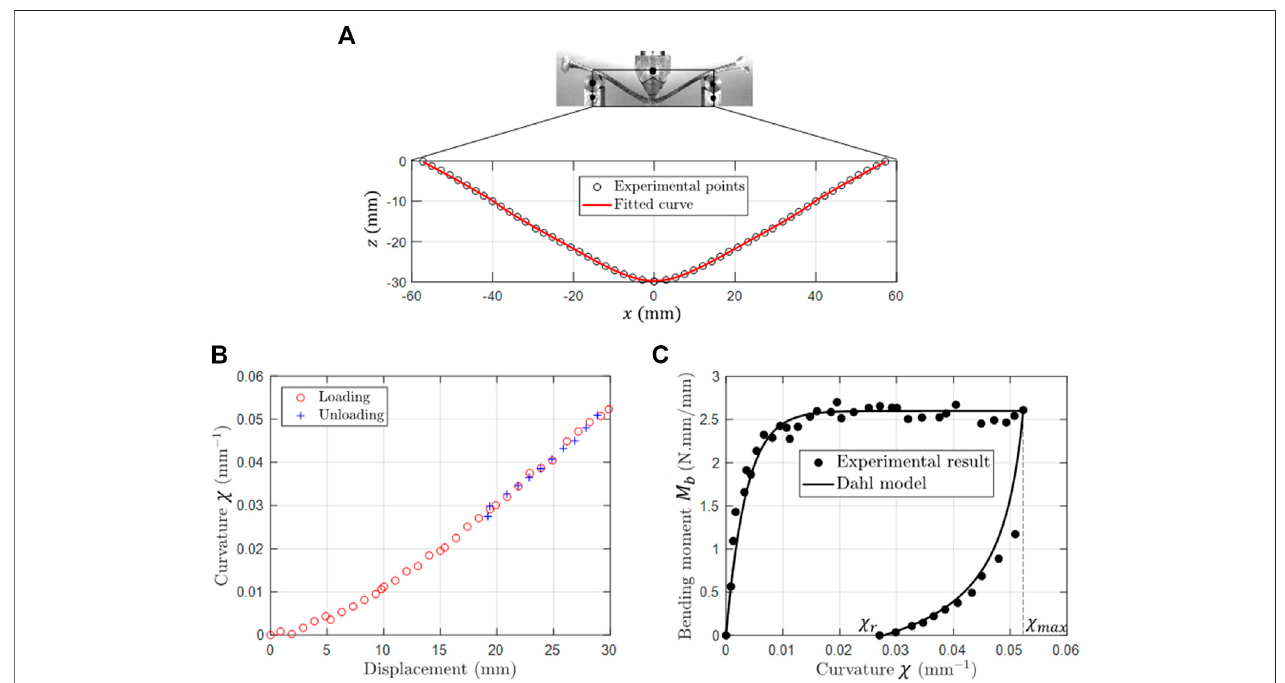
FIGURE4| Three-pointbendingtest (A) experimentalpointsand fi ttedcurveofthemid-lineattime t , (B) bendingcurvatureatthepointofapplicationoftheloadas a function of the displacement, (C) bending moment as a function of the curvature at the point of application of the load for a loading/unloading.